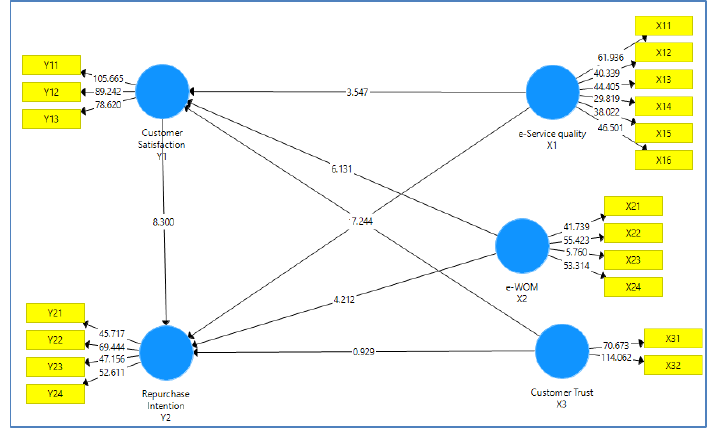
Fig. 2 . SmartPLS Path Analysis